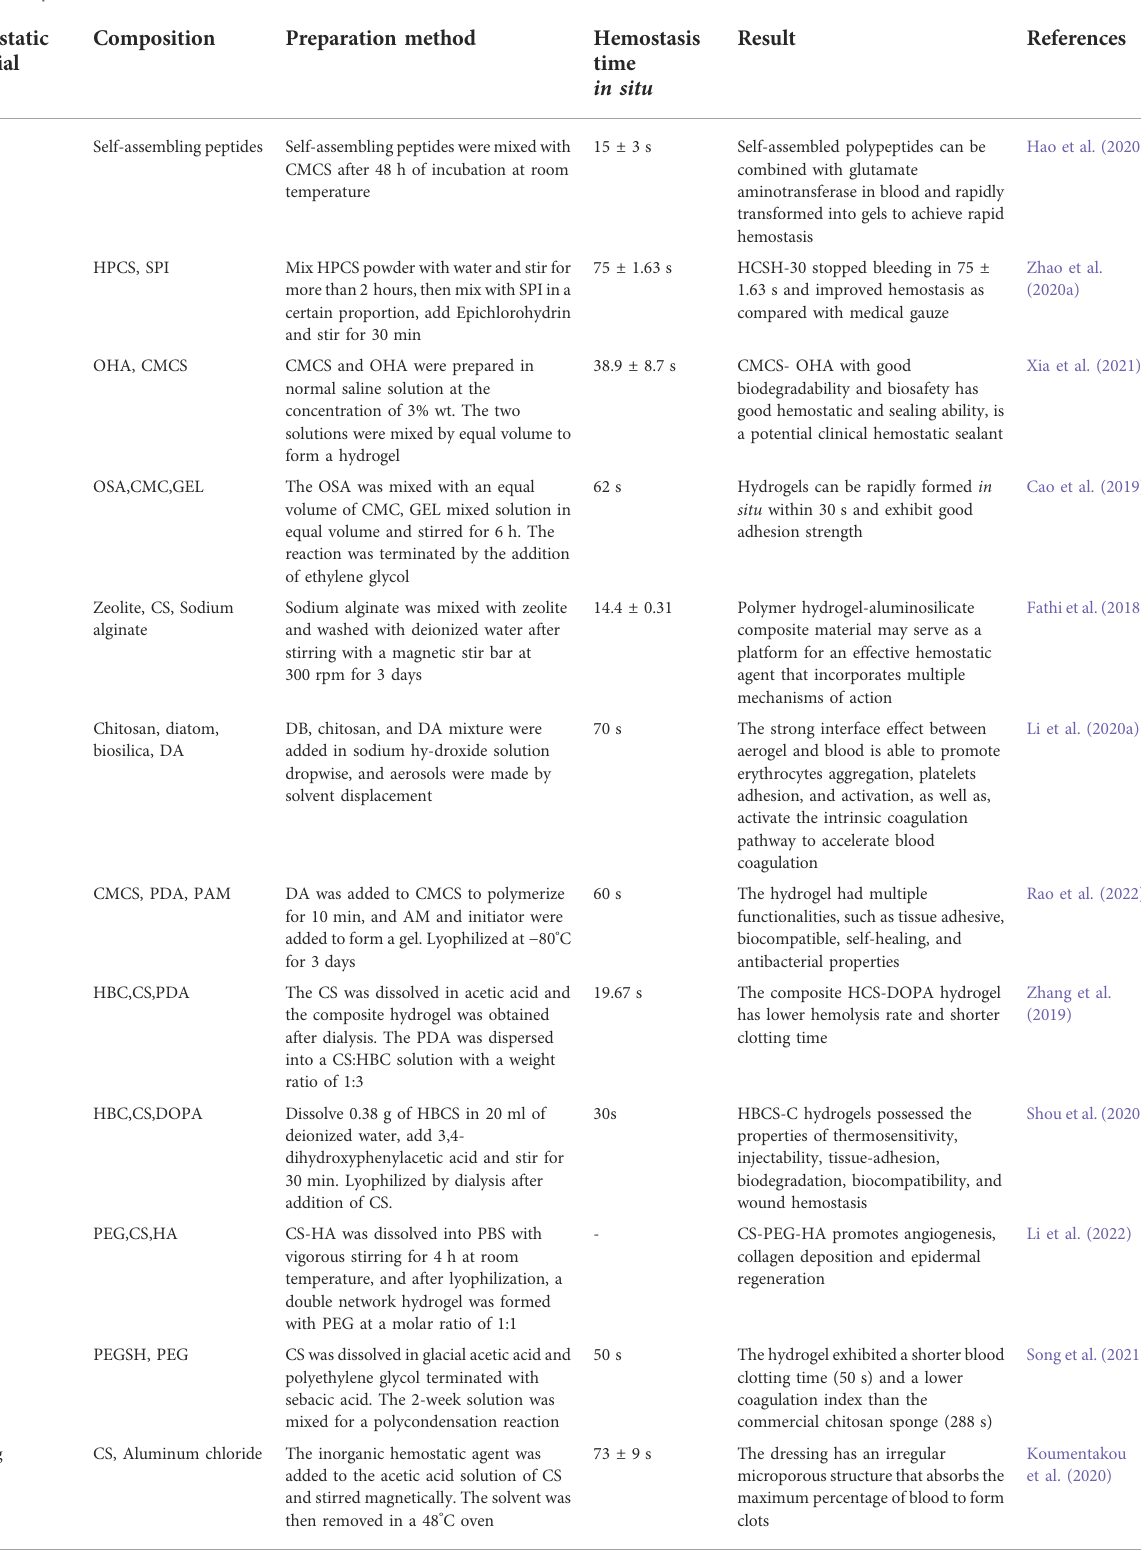
TABLE 1 Preparation method and hemostasis time of chitosan-based hemostatic material. Hemostatic